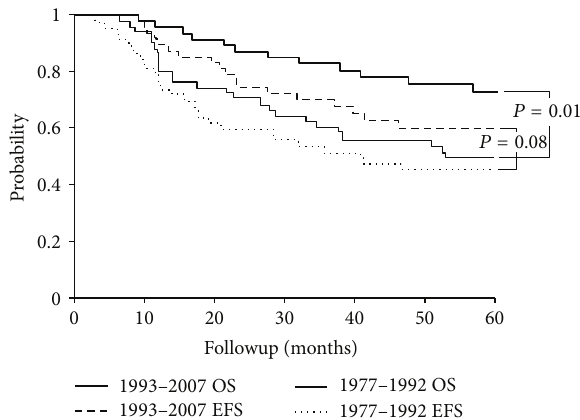
Figure 1: 5-year overall (OS) and event-free survival (EFS) by 1977– 1992 era and 1993–2007 era ( 𝑛 = 102 ).